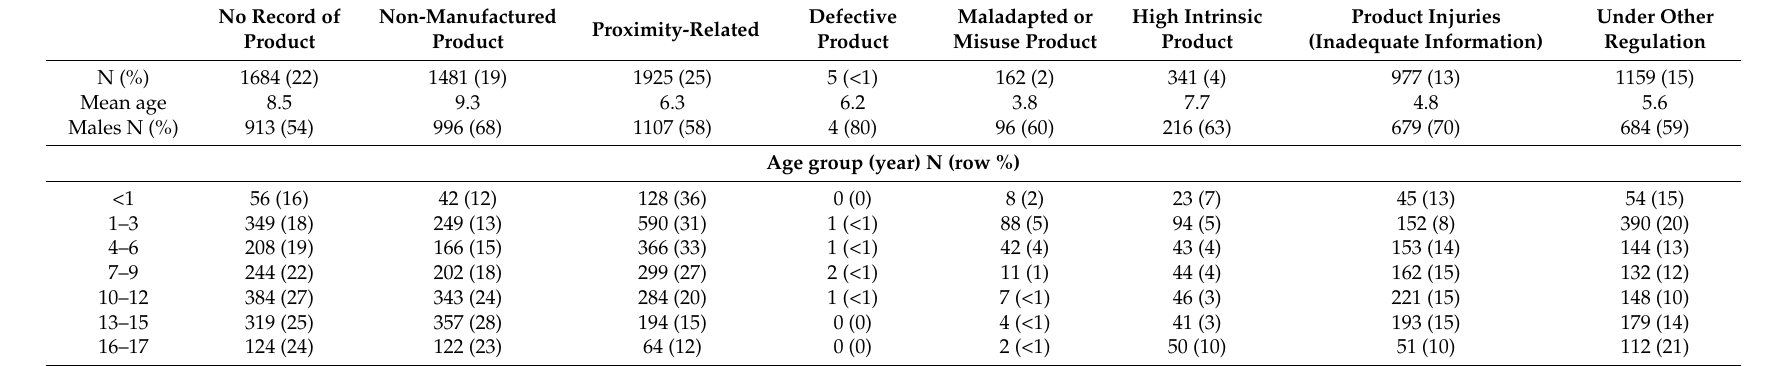
Table 2. Product involvement in sampled Queensland paediatric injuries